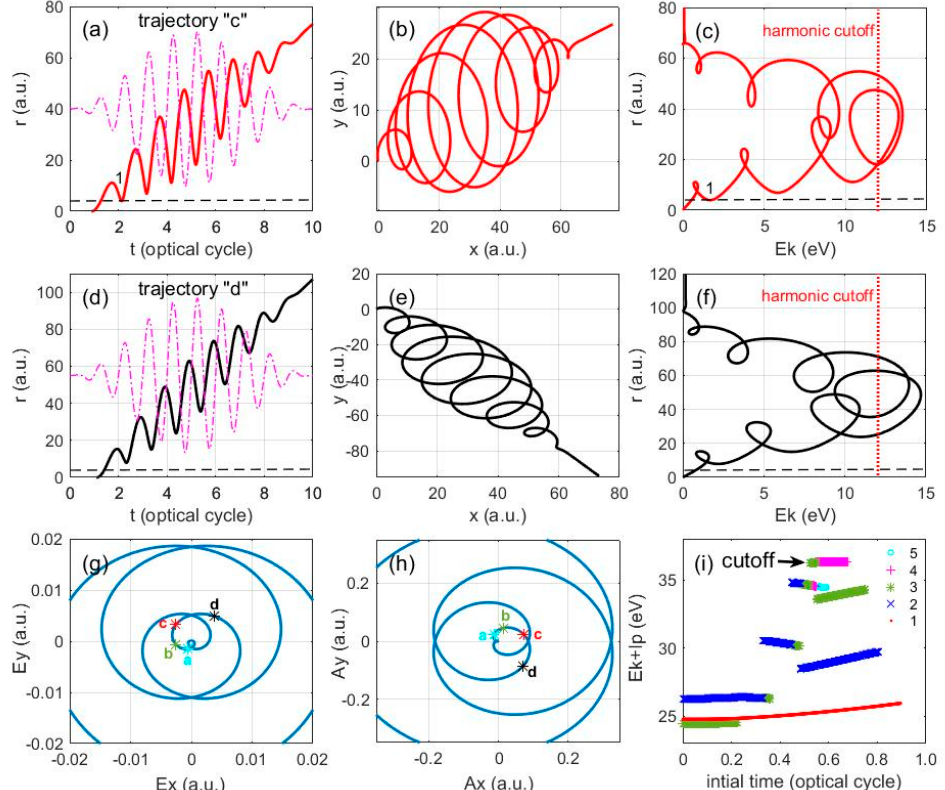
Figure 4. ( a – f ) Two typical trajectories for the sine-squared laser field. ( g ) The electric field and ( h ) the vector potential of the sine-squared laser field at the initial time for the four typical trajectories. ( i ) The return kinetic energy of the electron as a function of the initial time of the trajectory. The pink dash-dotted curves in panels ( a , d ) represent the x component of the driving field. The red dotted lines in panels ( c , f ) indicate the maximum return kinetic energy of the electron, which is consistent with the harmonic cutoff. The black dashed lines in panels ( a , c , d , f ) denote the position r = 4.0 a.u.